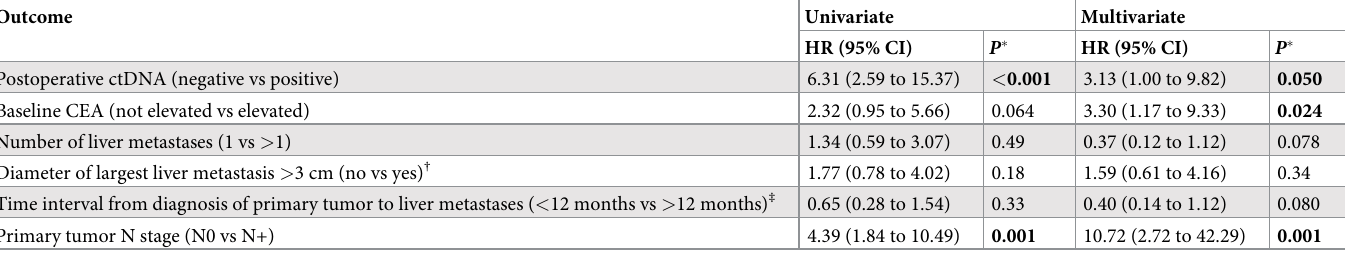
Table 2. Univariate and multivariate Cox regression for recurrence-free